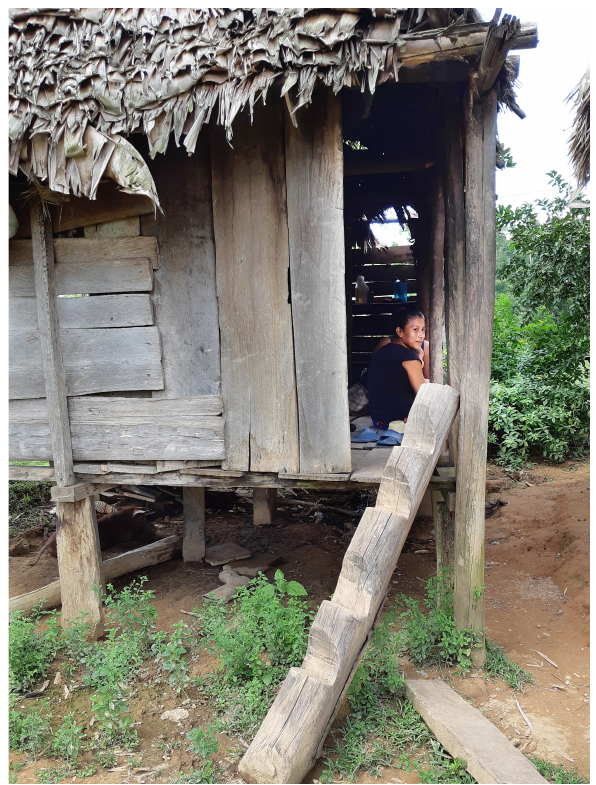
Figure 9. View of Pedro Taylor’s house in Santa María, Bonanza (Nathalia González).